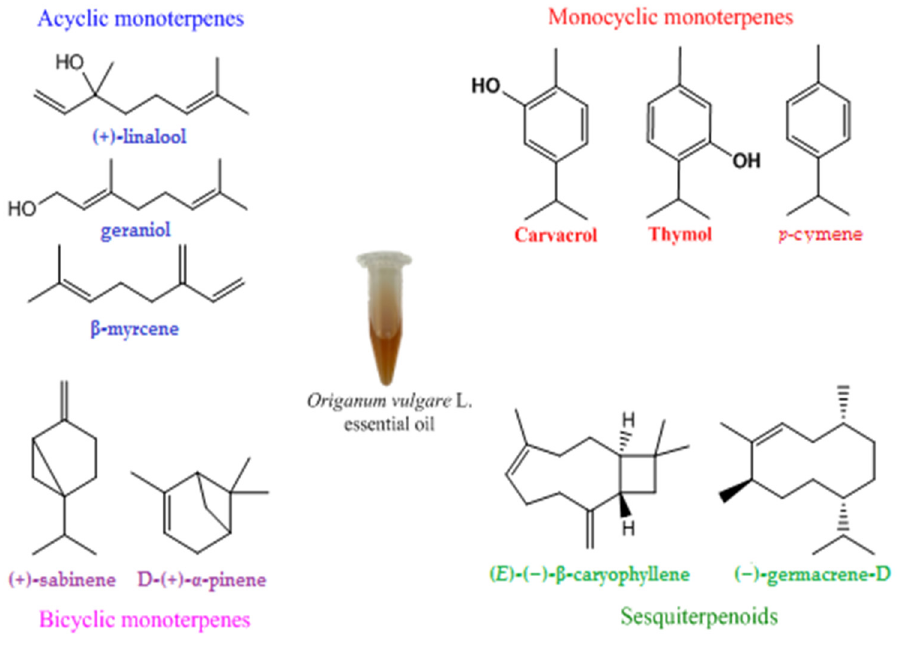
Figure 2. Chemical structures of main constituents of Origanum vulgare L. essential oil.